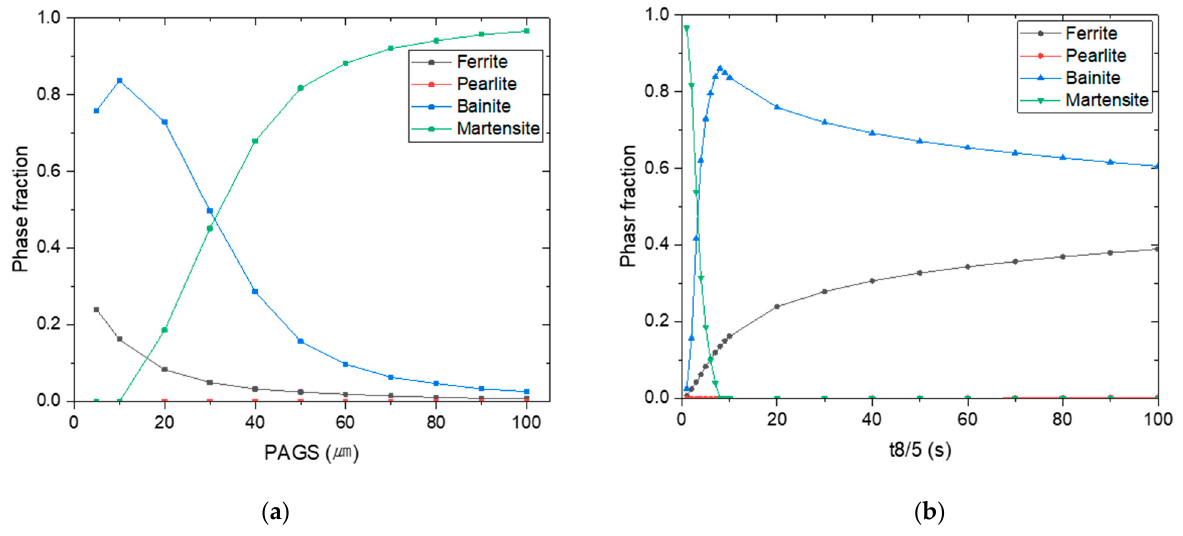
Figure 12. Phase fraction ( a ) according to PAGS when the t 8/5 is 2 s and ( b ) according to t 8/5 when PAGS is 50 µm. Table 5. Phase fraction according to PAGS when the t 8/5 is 2 s.